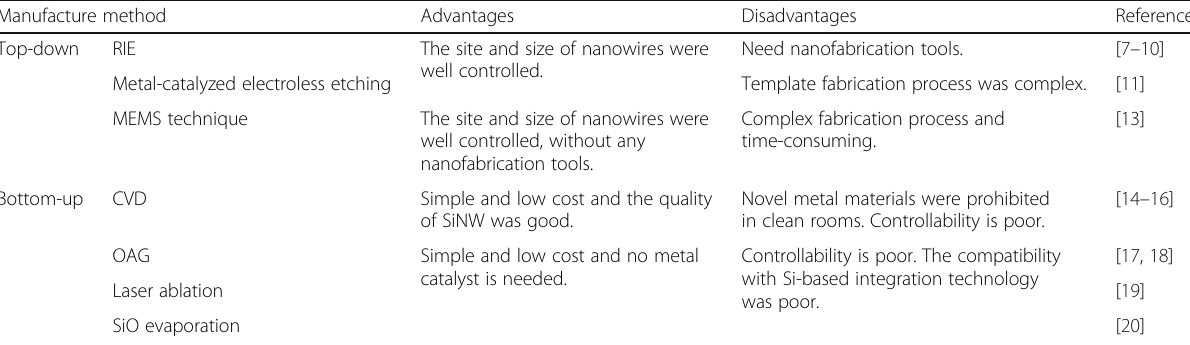
Table 1 Summary of different SiNW manufacture method